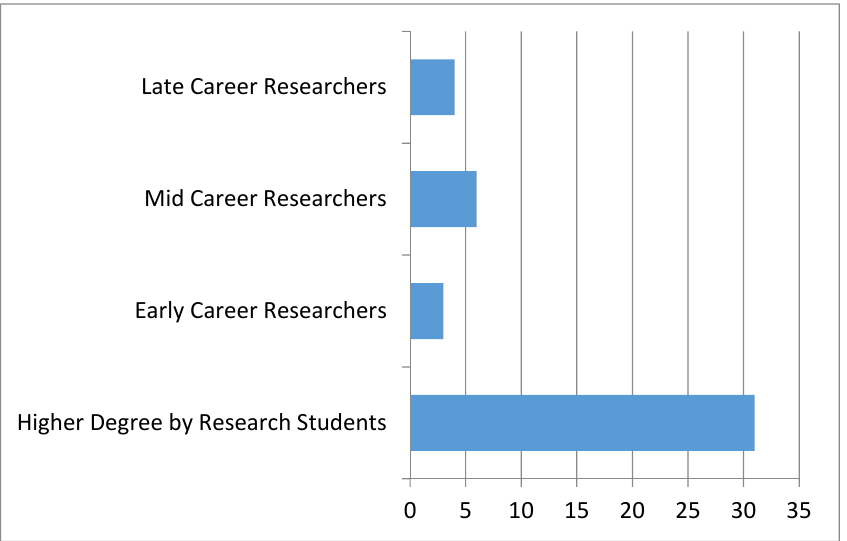
Figure 6. Career Stages of